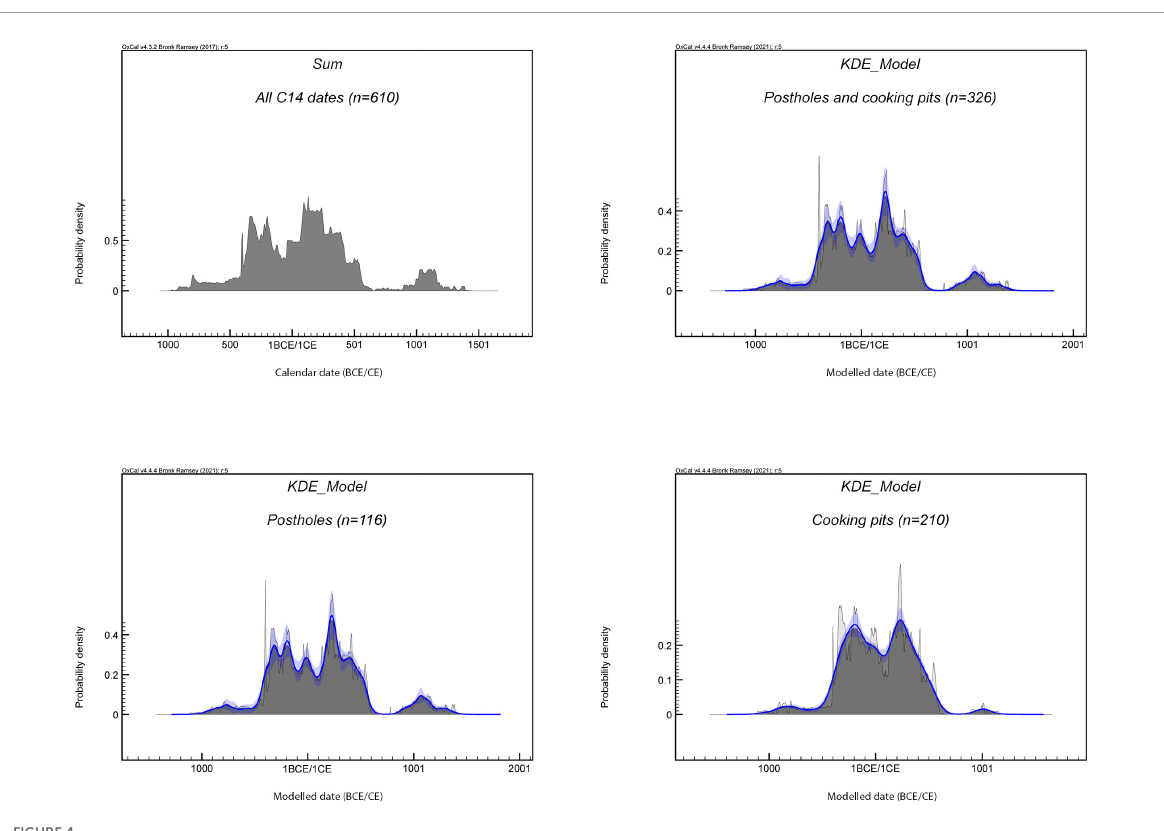
FIGURE4 Summed probability distribution (SPD) and Kernel density estimate (KDE) of radiocarbon dates from Vik archaeological